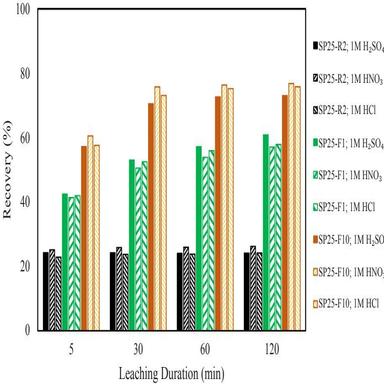
Leaching recoveries of the total REEs from the Guxu core segments.